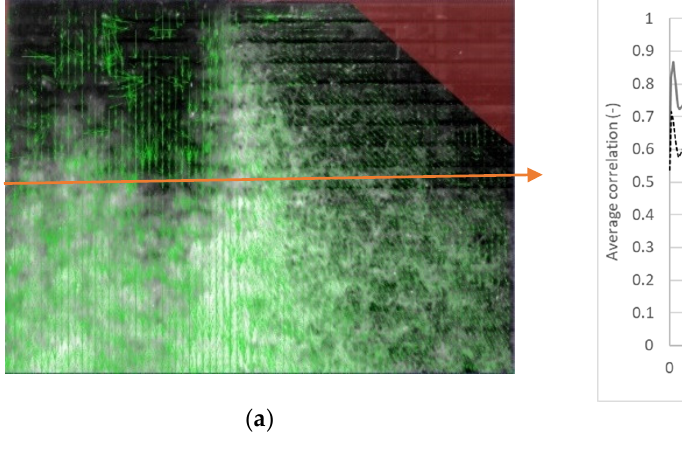
Figure 8. ( a ) Gross frontal velocity field obtained in frame 691 for d c / h = 2.38 for an interrogation area with 4 steps using decreasing size of the interrogation areas from 300 px to 50 px. ( b ) Time-averaged correlation for 400 fps and 200 fps across the chute width at L / L t = 0.30.